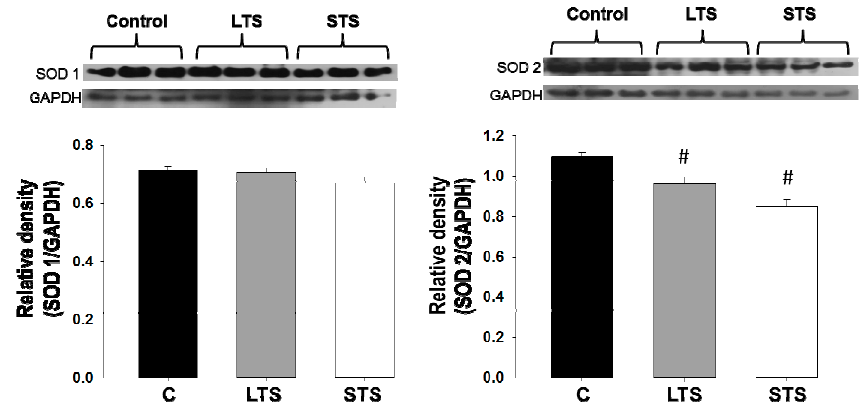
Figure 6. The effects of long-term (LTS) and short-term (STS) administration of sucrose on protein expression of the antioxidant enzymes SOD1 and SOD2. Data represent mean ± SEM, # p < 0.05, n = 8 lanes in Western blots in which homogenates of aortas from 8 different rats from each group were run. A representative Western blot analysis is shown above the graph.